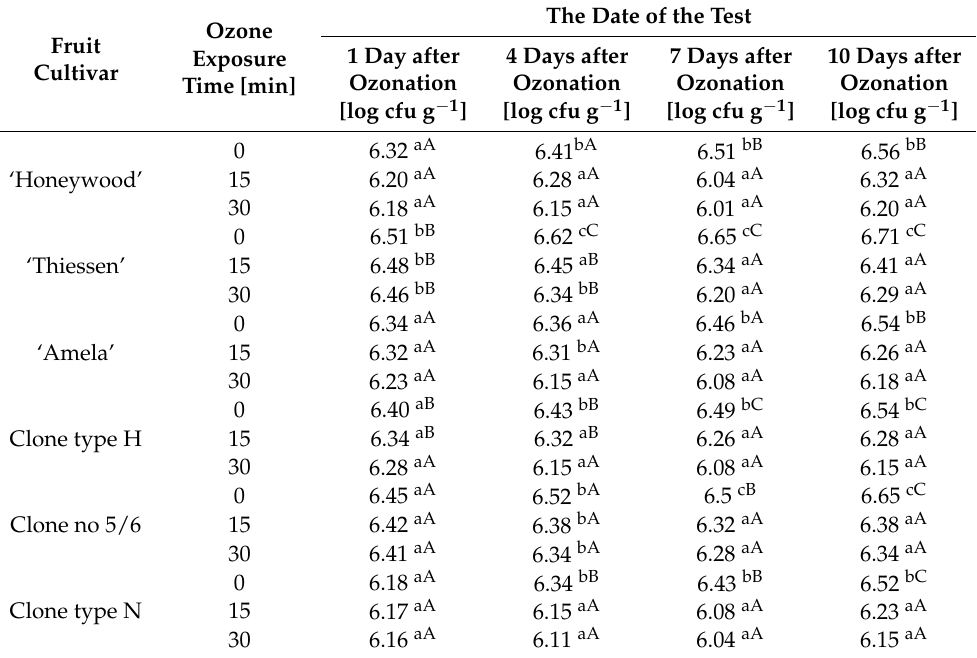
Table 1. Microbiological load of mesophilic aerobic bacteria in the fruit of Saskatoon berry during